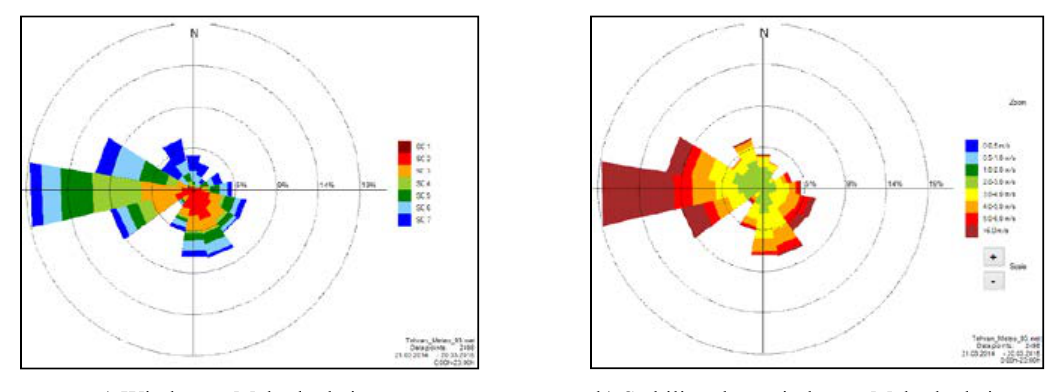
Fig. 1: The study area of Niayesh tunnel portals